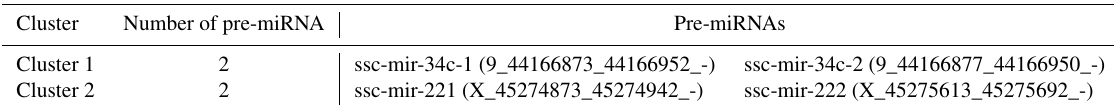
Table 4. Statistics table of upregulated miRNA clusters in exosomes. Cluster Number of pre-miRNA Pre-miRNAs Cluster